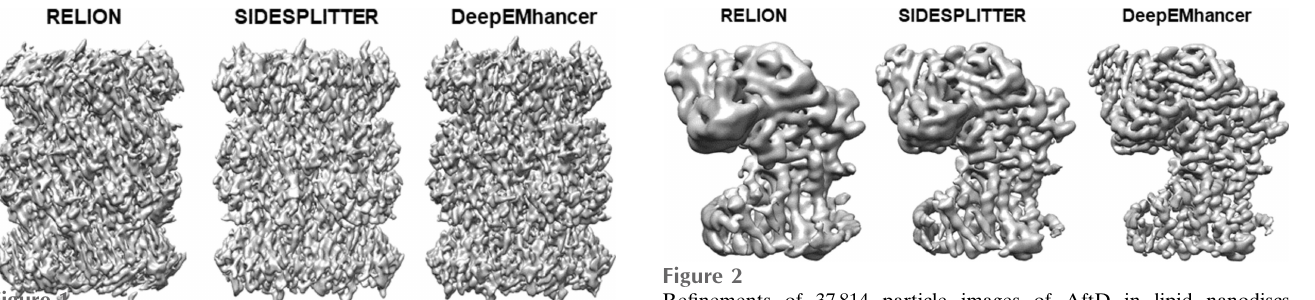
Figure 1 Refinement of synthetic data generated from the 20S proteasome structure (PDB entry 6bdf). Three different refinements were made using standard RELION , using SIDESPLITTER or incorporating deepEM- hancer .